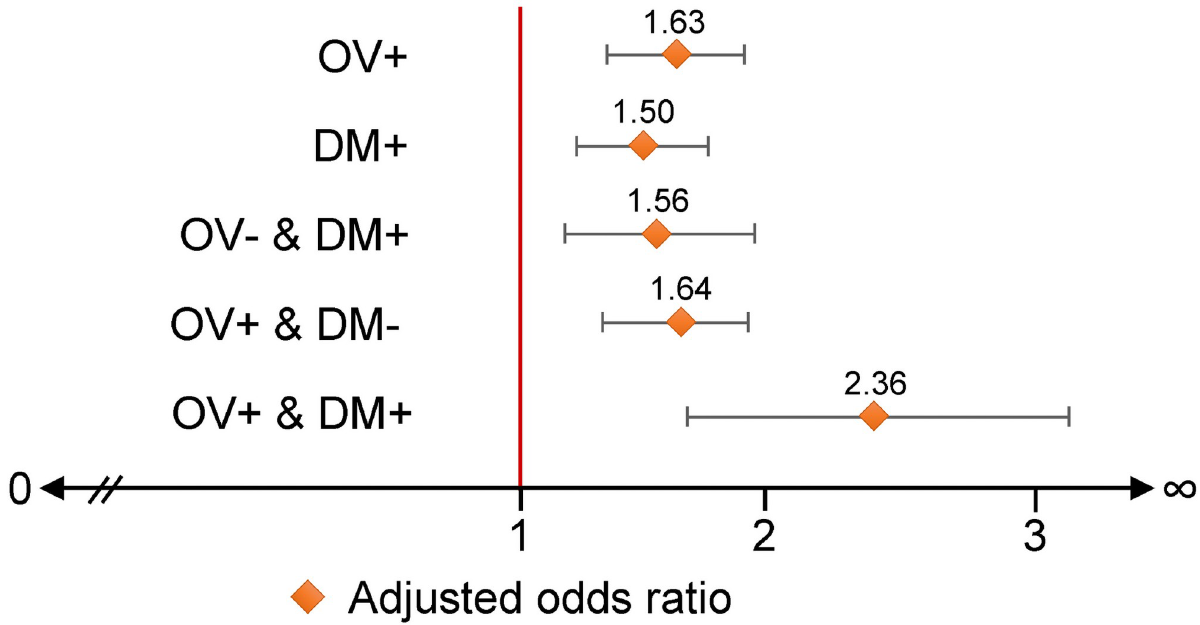
Fig 6. Adjusted odds ratios for the association of cholangiocarcinoma with O . viverrini infection and diabetes mellitus status. Data show the magnitude of association of cholangiocarcinoma, comparing groups infected with O . viverrini (OV+), diabetes mellitus (DM+), and combinations of these (OV- & DM+, OV+ & DM- and OV+ & DM+). In each case, the comparison is against the group without diabetes mellitus or O . viverrini